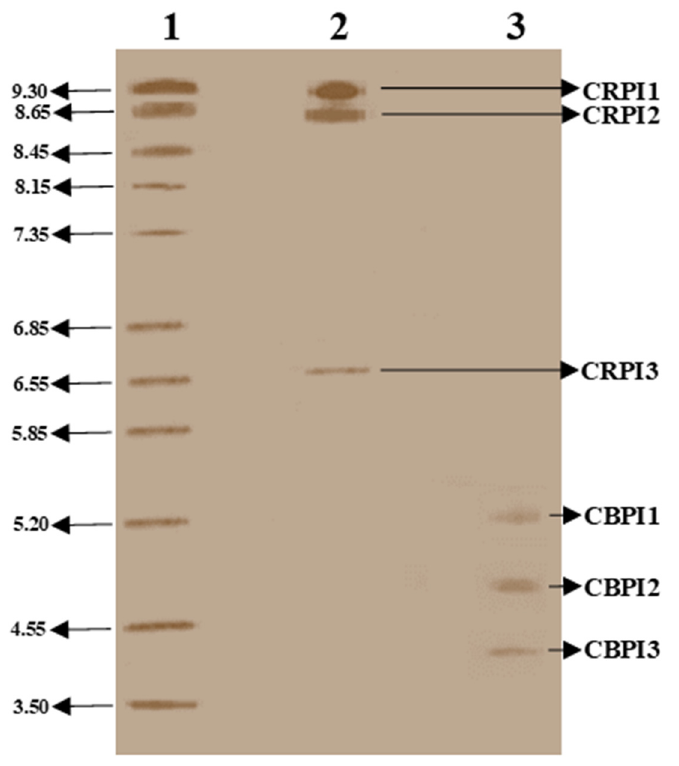
Figure 6. Isoelectric focusing gels (IEF gels 3–9 [pH range 3–9, Pharmacia]) were used for the purified protease inhibitors. Lanes 1 = markers with different isoelectric points (p I ) ranging from 3 to 10, 2 = Rivette PIs, and 3 = BLN-3347 PIs.